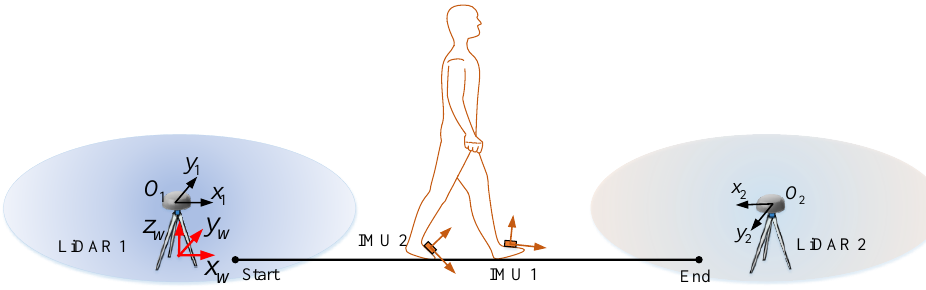
Figure 1. System overview: a dual foot-mounted IMU and multiple 2D